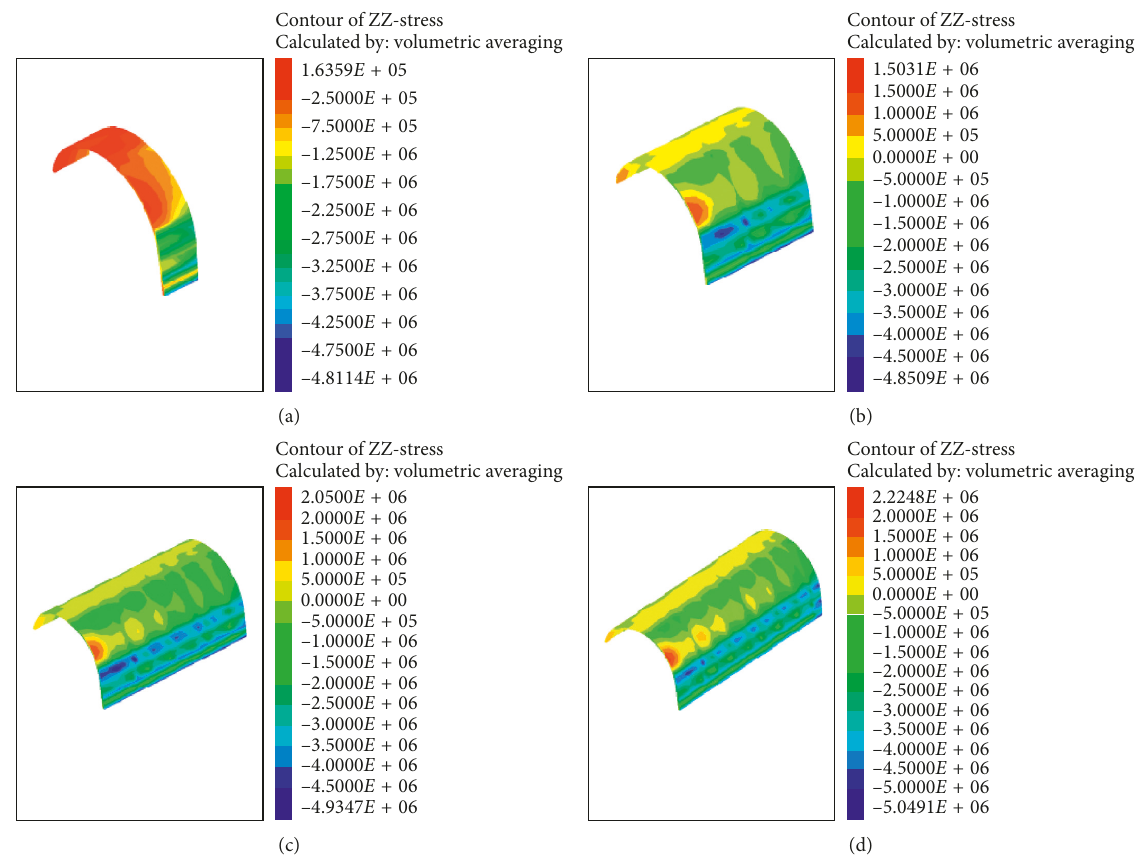
Figure 13: Vertical stress of tunnel surrounding rock under different excavation distances: (a) excavation of 3 m; (b) excavation of 12m; (c) excavation of 21m; (d) excavation of